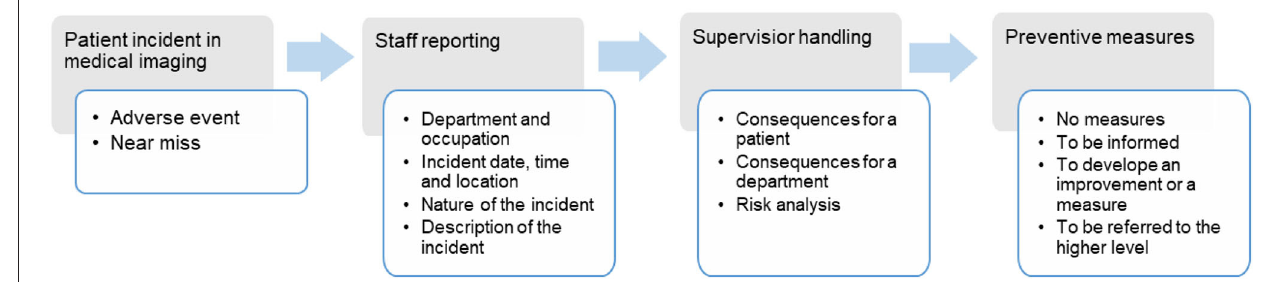
FIGURE 1 | The sequence of the patient incident reporting